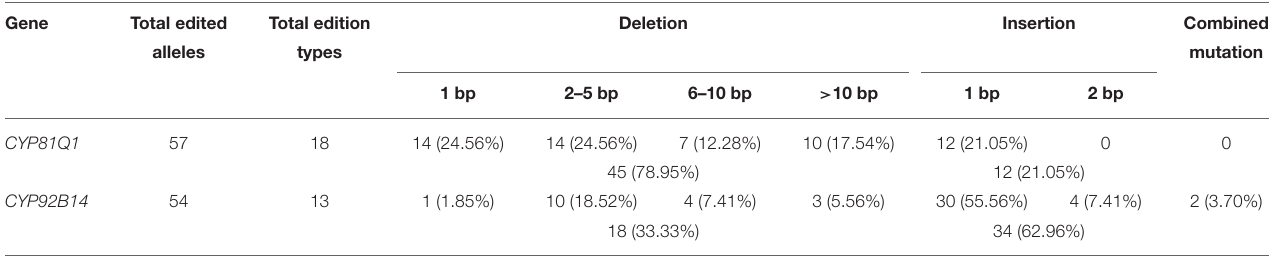
TABLE 2 | Characterization of mutation types in each target